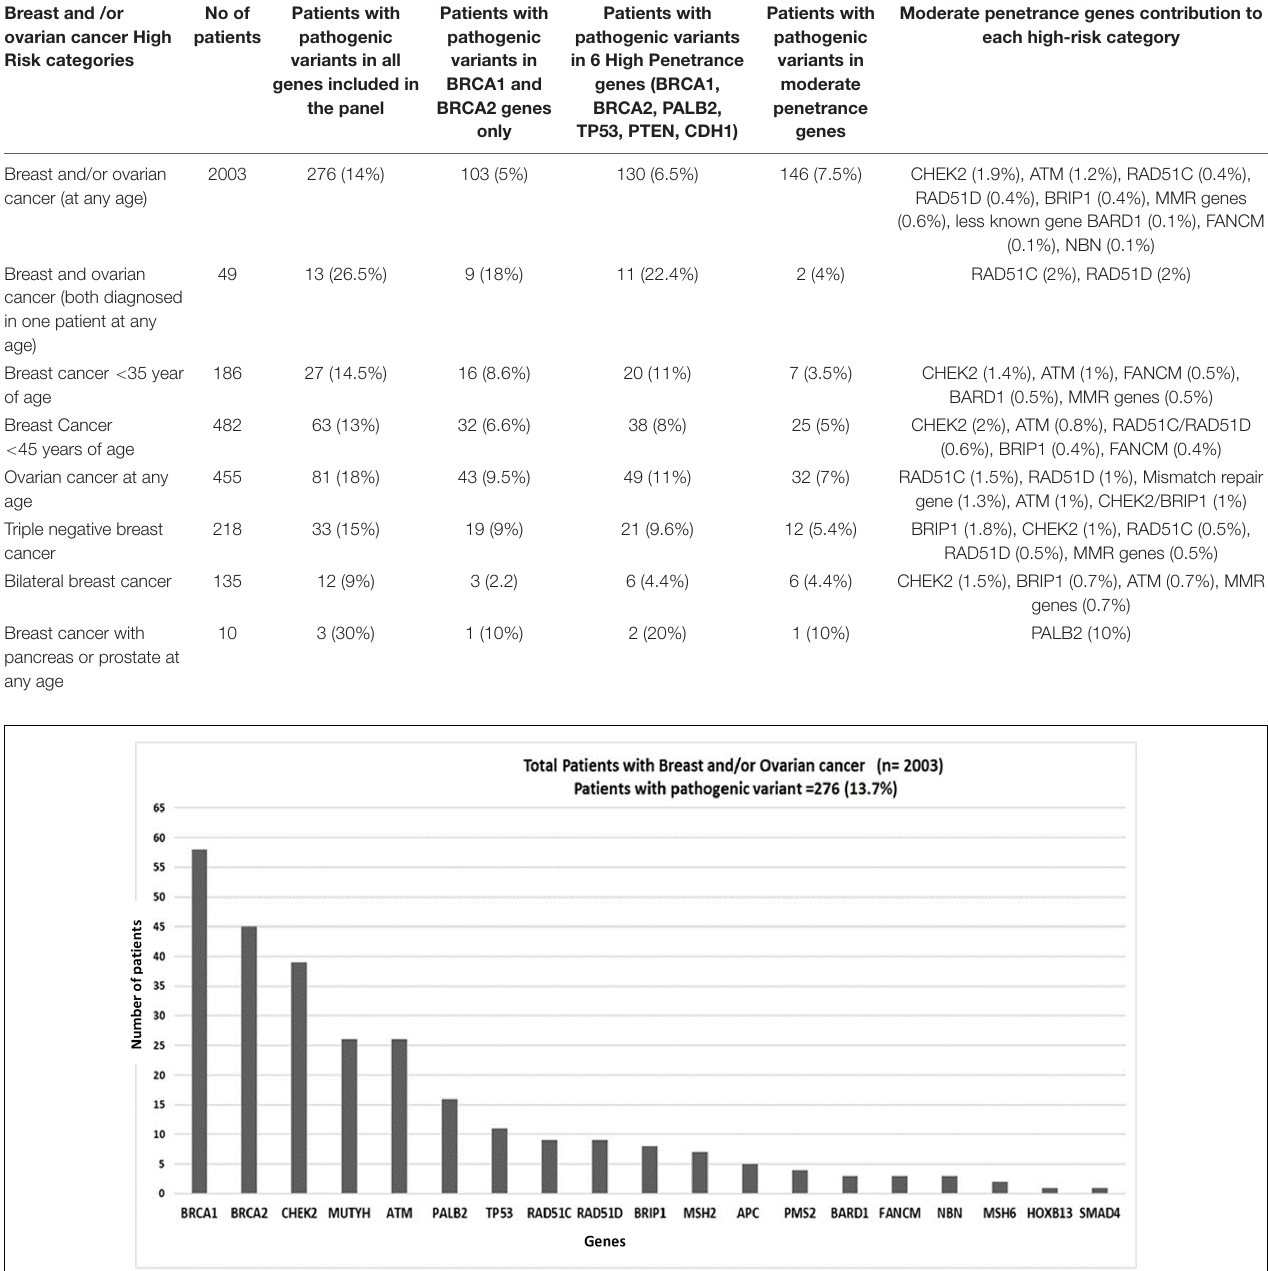
in Figure 5 . Frequency of different types of PVs (CNVs, nonsense, missense, deletion, insertions) is depicted in Figure 2